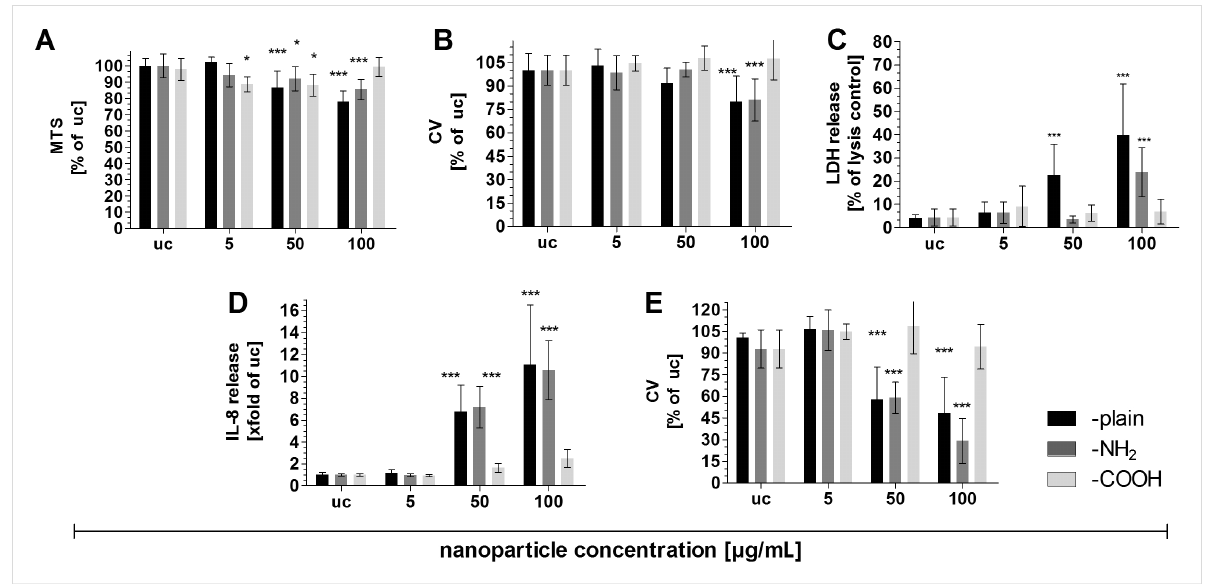
Figure 1: Comparison of cytotoxic effects on A549 after 4 h stimulation with aSNPs displaying different surfaces (–plain, –NH 2 , –COOH; 5–100 µg/mL, untreated control (uc)). A: Cell viability (mitochondrial activity, MTS, % of untreated control (uc)); B: cell viability (crystal violet staining of nuclei, cell loss measurement, % of uc); C: LDH release (membrane integrity, % of lysis control; D: IL-8 release after 4 h stimulation with 20 h further cultivation in fresh cell culture medium; E: cell viability (crystal violet, cell loss measurement) correlated to IL-8 (after 4 h stimulation with 20 h further cultivation in fresh cell culture medium). Data are depicted as means ± S.D. of 3 independent experiments with n = 3. For statistical analysis two-way ANOVA with Bonferroni’s post test was conducted. * P < 0.05, ** P < 0.01 and *** P < 0.001 compared to the untreated control.